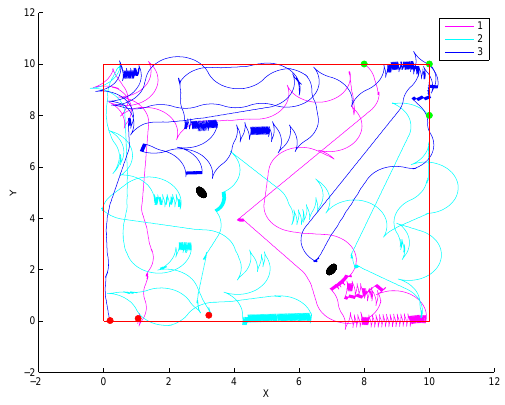
Fig. 2. Robot trajectories and obstacle positions relative to the cov- erage